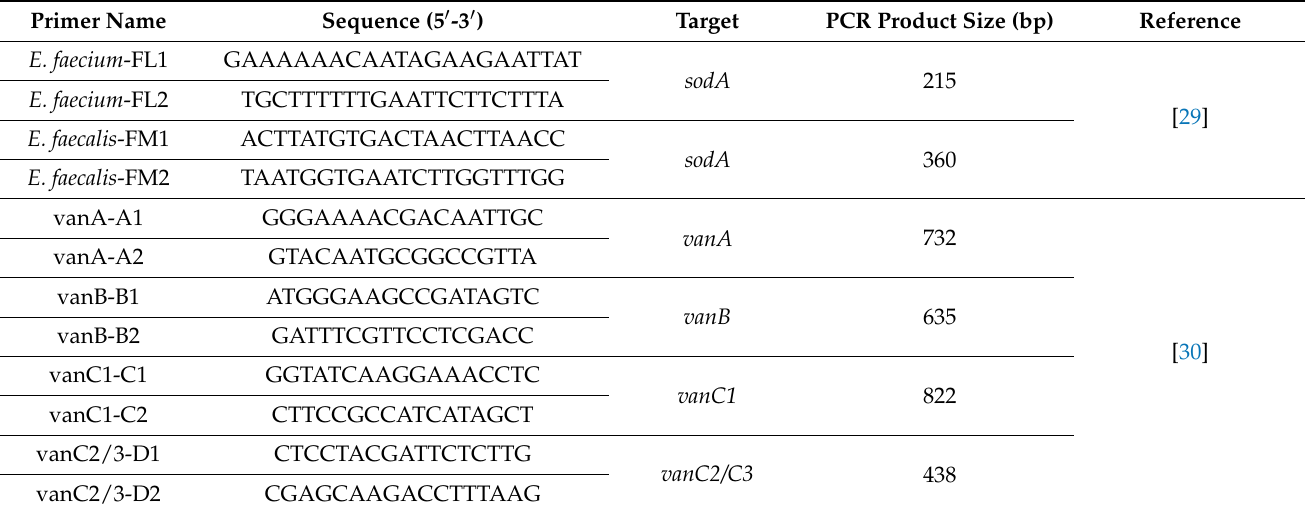
Table 4. Primers used in multiplex PCR in current